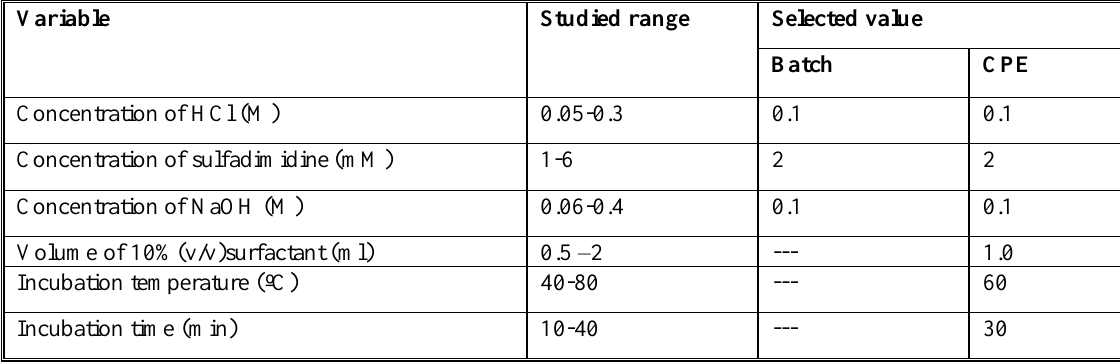
Table 1. Summary of studied variables with optimum values for assay of ISX using batch and CPE methods Variable